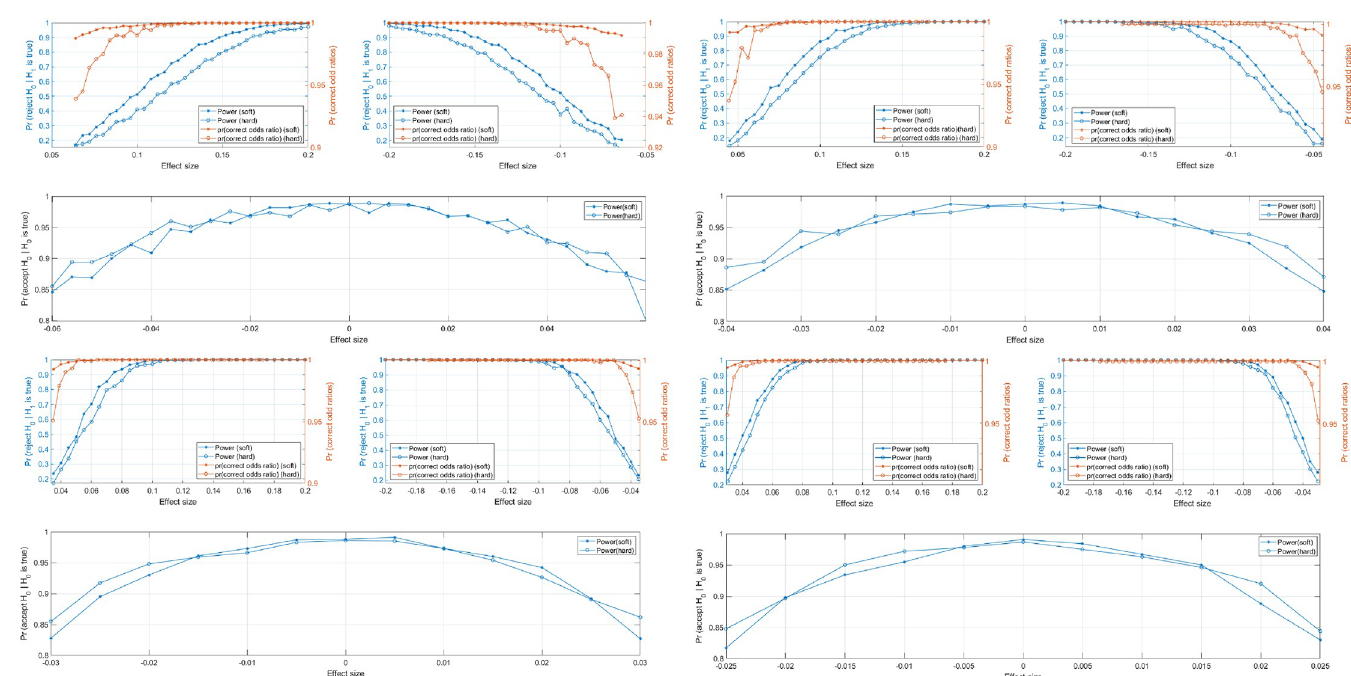
Fig 6. The pr ( reject H 0 | H 1 is true ) and pr ( accept H 0 | H 0 is true ) at (a) M = 250, (b) M = 500, M = 1000 and M =